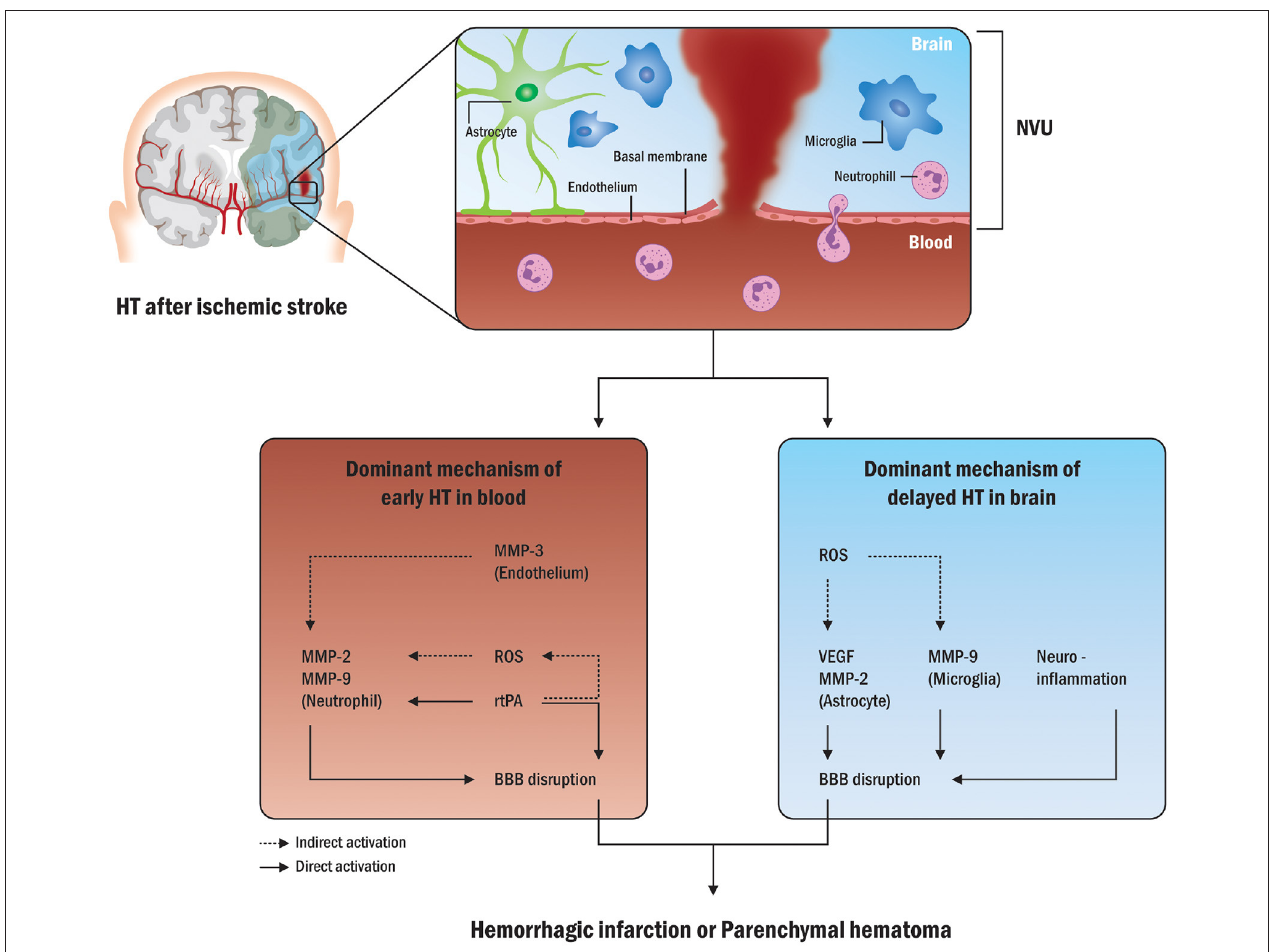
FIGURE 2 | Possible mechanisms in early and delayed HT. The disruption of the BBB is a common pathway in HT formation following acute ischemic stroke. Various molecules from neutrophils and peripheral blood in possible processes in early HT are mainly associated with HT after ischemic stroke. Exogenous tPA can also increase MMP-9 levels by activating neutrophils and increasing MMP-2 levels. Conversely, in possible processes for delayed HT, the brain tissue is a major source of MMP-9 within the first 18–24h following stroke, and endogenous tPA can act on endothelial cells to increase MMP-2 release from astrocytes as well as MMP-9 release from microglia. HT, hemorrhagic transformation; NVU, neurovascular unit; MMP, matrix-metalloproteinase; ROS, reactive oxygen species; tPA, tissue plasminogen activator; BBB, blood-brain barrier; VEGF, vascular endothelial growth